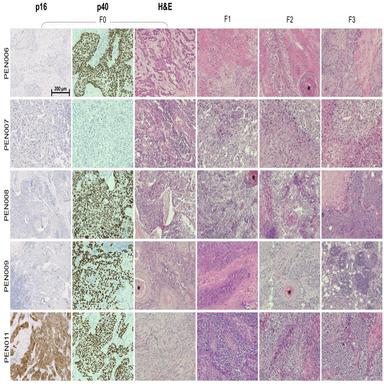
Immunohistochemical characterization of original patient tumor samples (F0) via p16 staining, p40 staining, and hematoxylin and eosin (H&E) staining at 203 magnification. H&E stains demonstrate histological SCC identity of patient-derived xenograft models during several passages (F1, F2, F3). Keratin pearl formation, a pathognomonic feature of SCC, is denoted with an asterisk ().